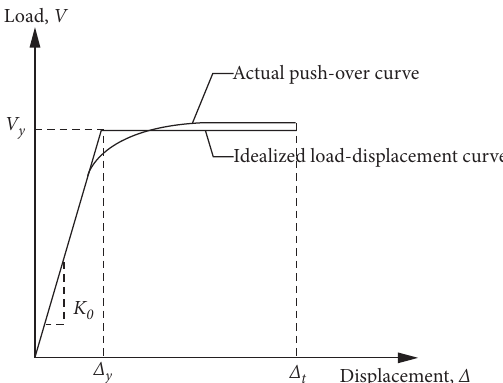
Figure 18: General idealized relationship of shear loading versus displacement.